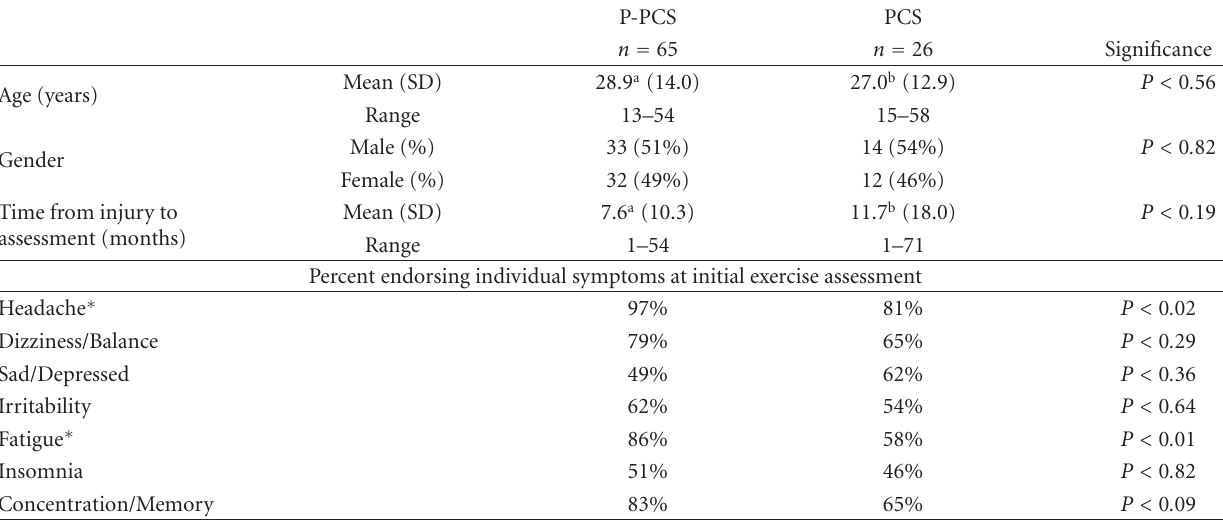
Table 1: All patients in the P-PCS (could not exercise to maximum capacity) and PCS (could exercise to maximum capacity) groups.